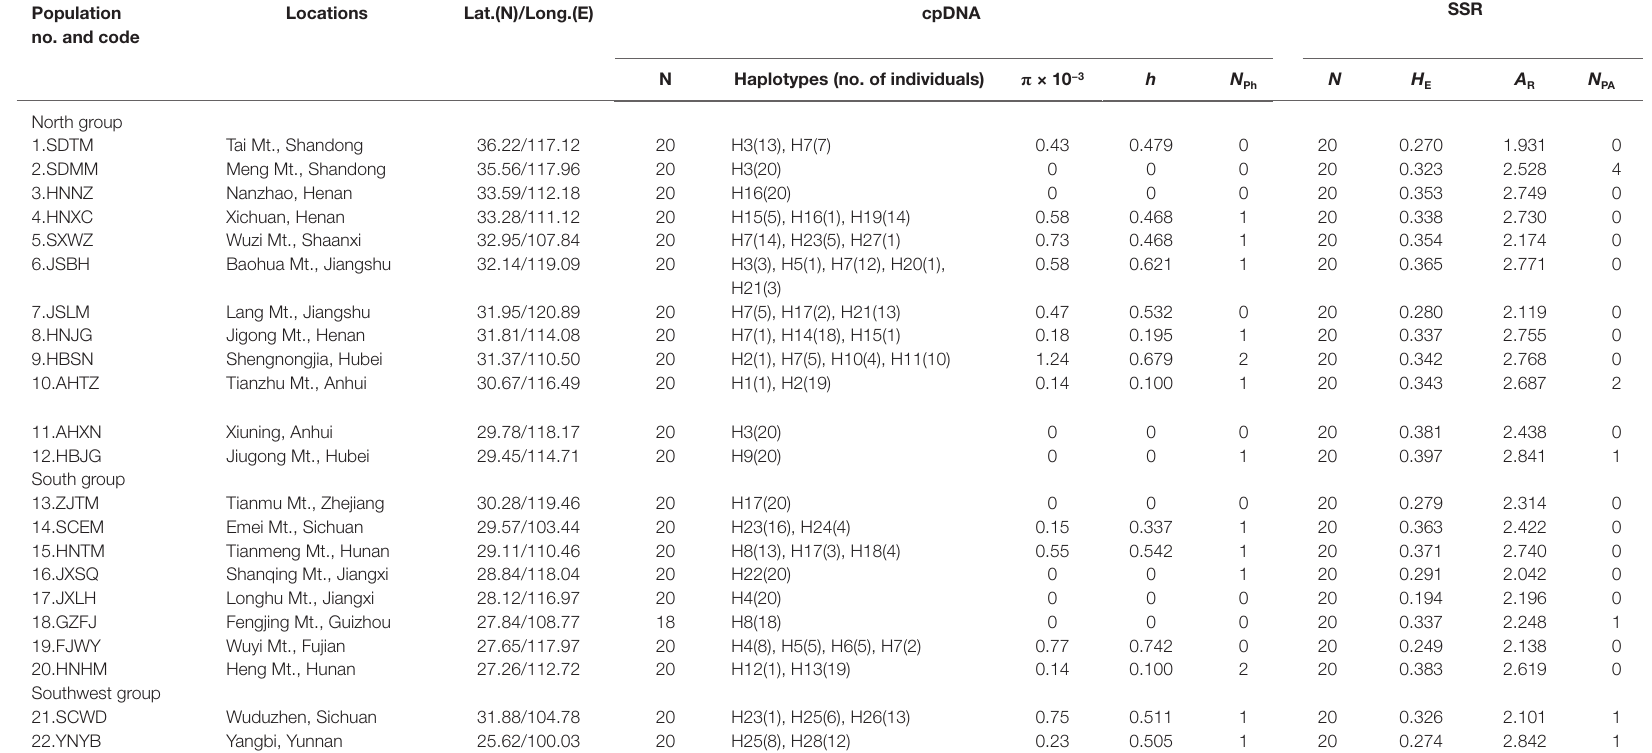
TABle 1 | Details of population locations, sample size, cpDNA, and SSR variation of Pterocarya stenoptera sampled in China. Population no. and